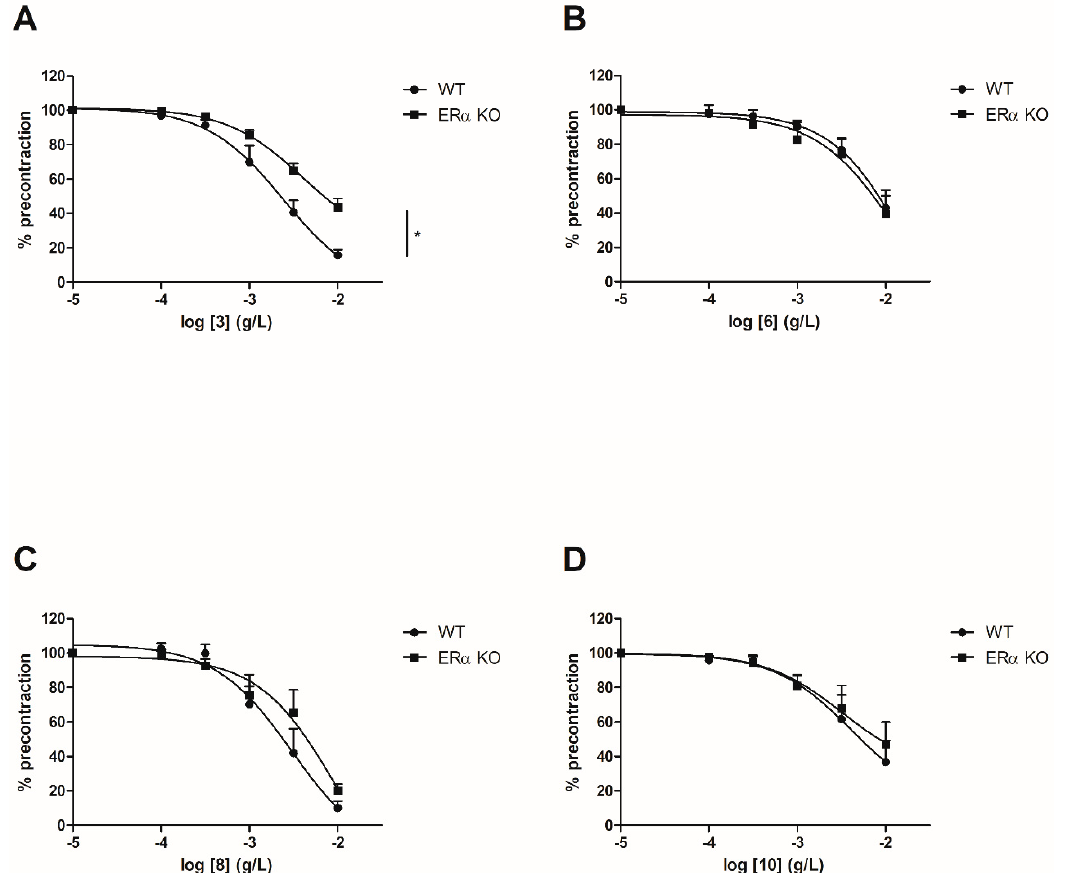
Figure 2. Concentration-response curves for the vasorelaxation effect on both WT and ER α KO mice thoracic aorta of synthetic chalcones 3 ( A ), 6 ( B ), 8 ( C ) and 10 ( D ). Mice were ovariectomized 7 days before the experiment. Vessels were pre-contracted with U46619, phenylephrine, and serotonin, at 80 % of their maximal response. The presence of functional endothelium was assessed by determining the ability of acetylcholine (10 µM) to induce more than 50% relaxation of pre-contracted rings. Results are expressed in percentage of precontraction (y-axis) following the concentration (x-axis). Only the synthetic chalcone 3 induced a significant lower vasorelaxation in ER α KO mice thoracic aorta rings compared to WT mice thoracic aorta rings (56.23 ± 4.91% vs 84.28 ± 3.24% respectively) while no significant differences were observed with chalcones 6 , 8 and 10 . N = 4–7, * p < 0.05 (Mann- Whitney).